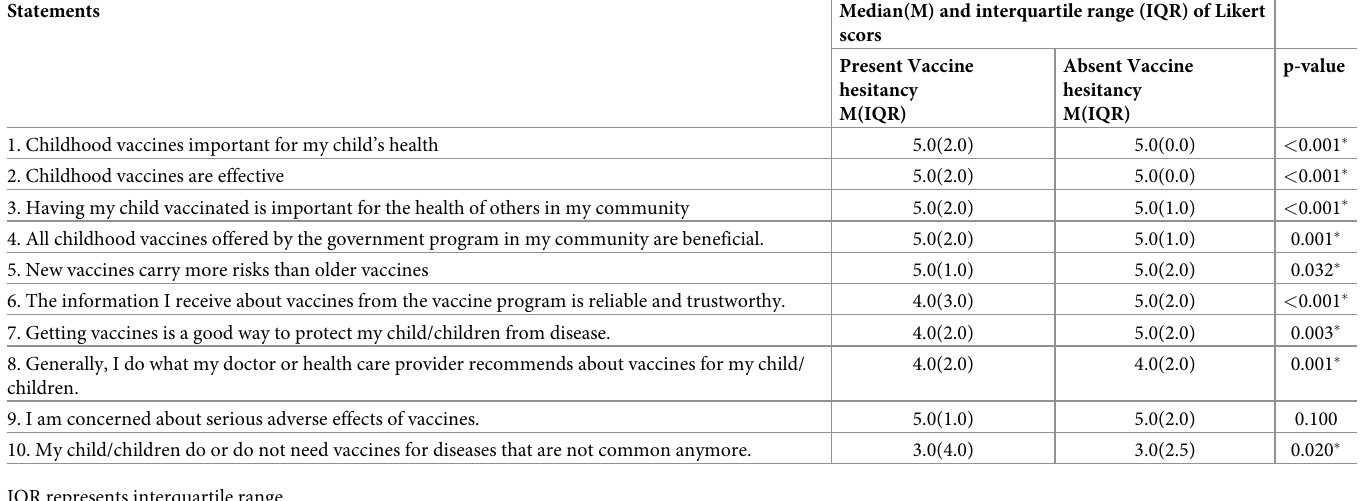
Table 4. Parents opinion on vaccination in